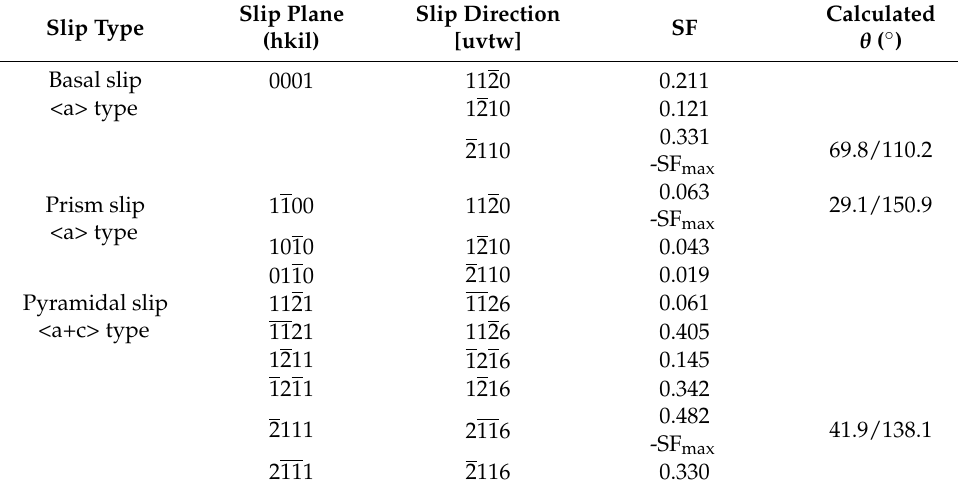
Table 2. The analysis of the activated slip system for #10 α 2 grain.